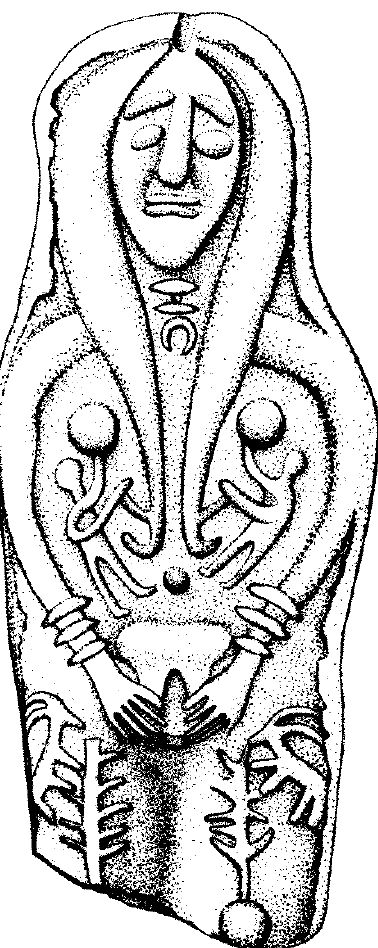
Figure 14. Revadim plaque figurine of a naked woman with babies wearing a crescent pendant (Ornan 2007: Figure